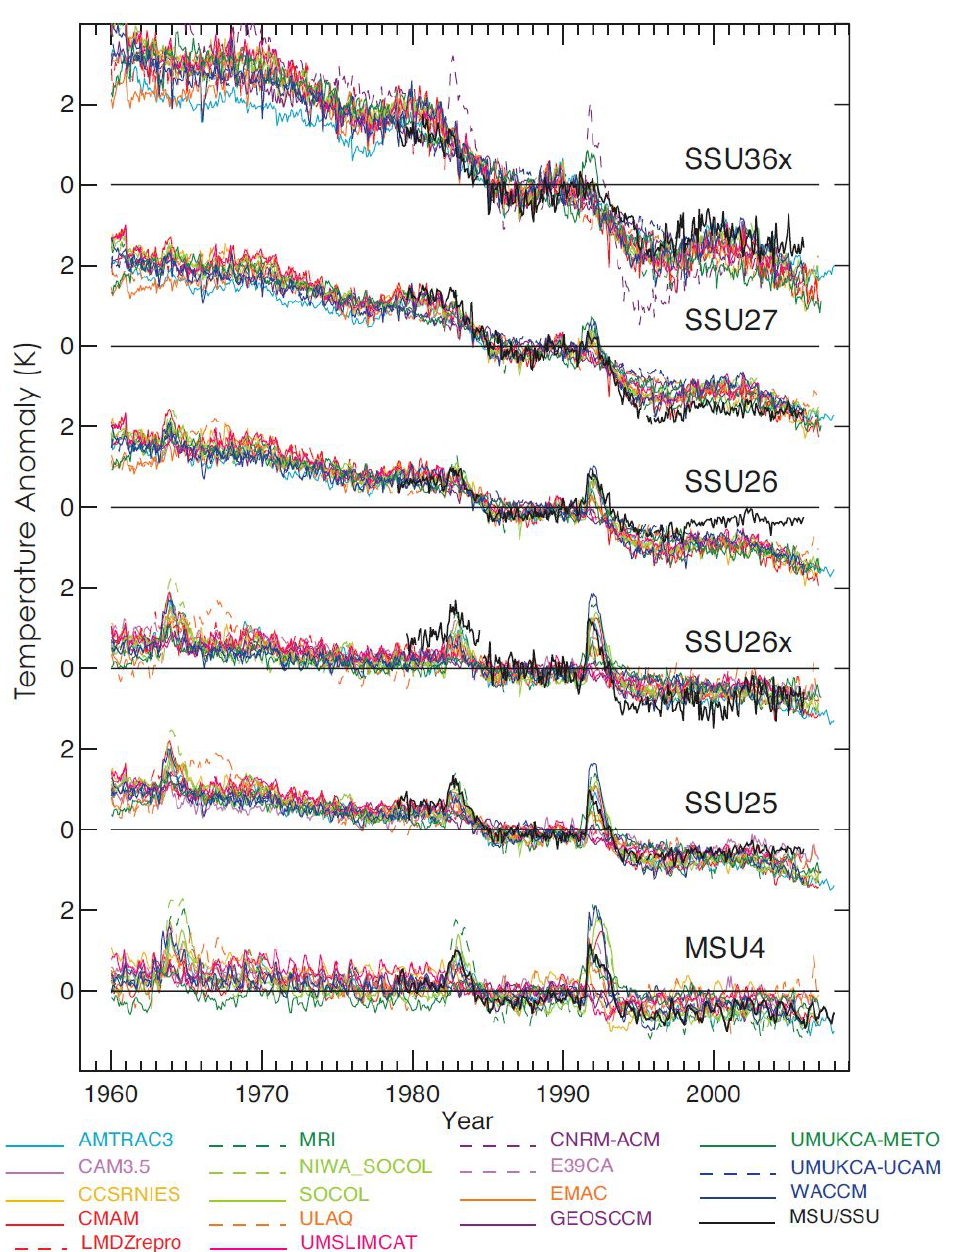
Figure 2. Global mean time series of satellite observed (black lines; from [41]) and CCM (colored lines) temperature anomalies (in K) weighted for Microwave Sounding Unit/Stratospheric Sounding Unit (MSU/SSU) weighting functions. The anomalies are calculated with respect to the period of 1980–1994. Exact weighting functions for the MSU/SSU satellite instruments are given in [41]. Channel 27 corresponds to ~34–52 km altitude, channel 36x to ~38–52 km, channel 26 to ~26–46 km, channel 25 to ~20–38 km, channel 26x to ~21–39 km, and channel MSU4 to ~13–22 km. (Figure 4–10 in